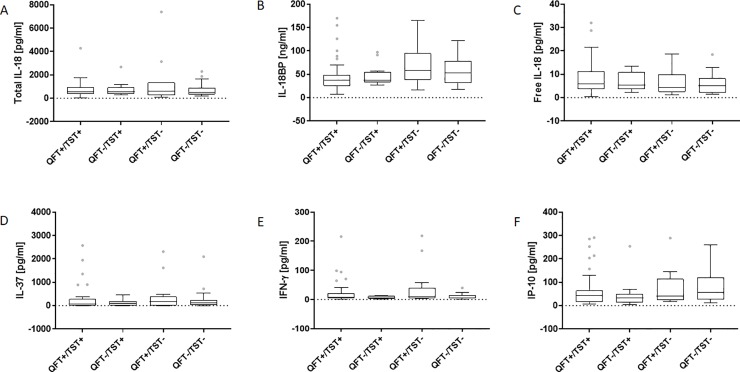
Serum levels of total IL-18, IL-18BP, free IL-18, IL-37, IP-10 and IFN-γ versus QFT/TST results.Boxplots with median (horizontal line within the box), interquartile range (box limits), and extremes (whiskers) of serum levels of total IL-18 (A), IL-18BP (B), free IL-18 (C), IL-37 (D), IFN-γ (E) and IP-10 (F) in the group of active tuberculosis patients with positive or negative QuantiFERON (QFT) and tuberculin skin test (TST) results.